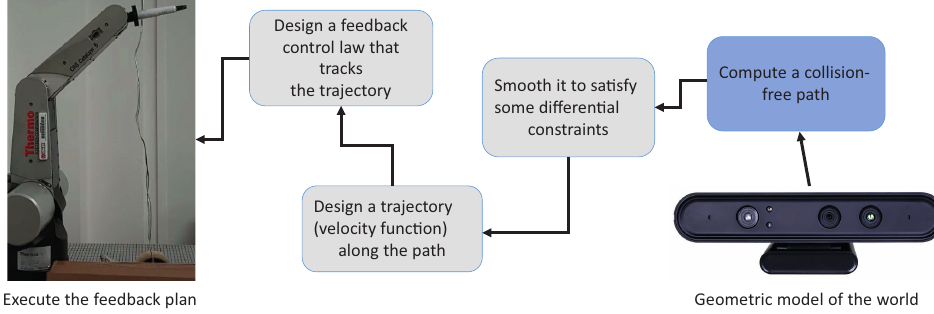
Figure 1. Refinement approach for autonomous robotic